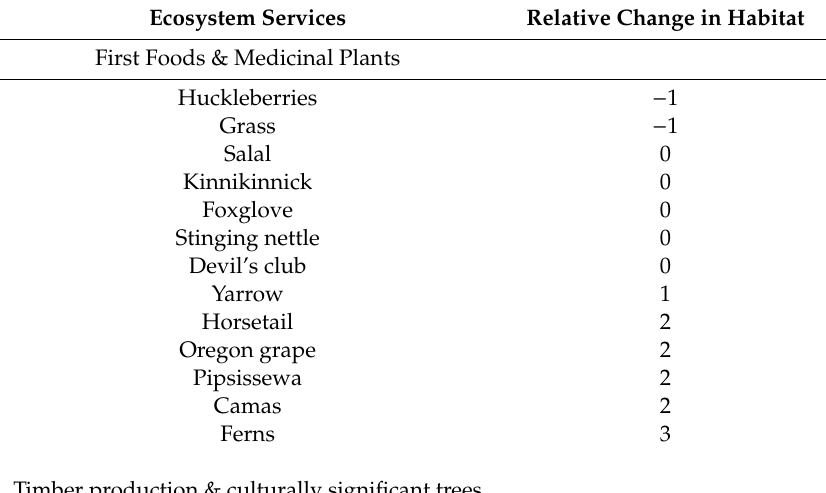
Table A2. Tribally important ecosystem services and their relative change in habitat as related to